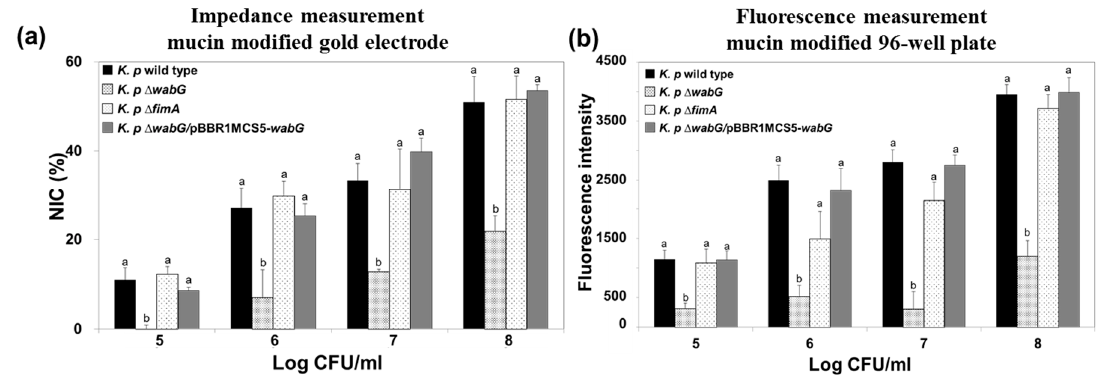
Figure 7. Impedance measurements ( a ) and conventional measurements obtained using the 96-well plate/fluorescence method ( b ) for the adhesion of K. pneumoniae KCTC 2242 and of its isogenic mutants to mucin modified surfaces. For impedance measurements, normalized impedance change (NIC) at 0.1 Hz was used to measure the adhesion of bacteria to mucin surfaces. Increases in impedance signals were proportional to number of bacteria in the range from 10 5 to 10 8 CFU/mL K. pneumoniae KCTC 2242 ∆ wabG showed the lowest level of interaction with mucin surfaces. Mean values with different superscripts (a,b) at each bacterial concentration indicate significant differences between the wild type and its isogenic mutant strains ( p < 0.05).